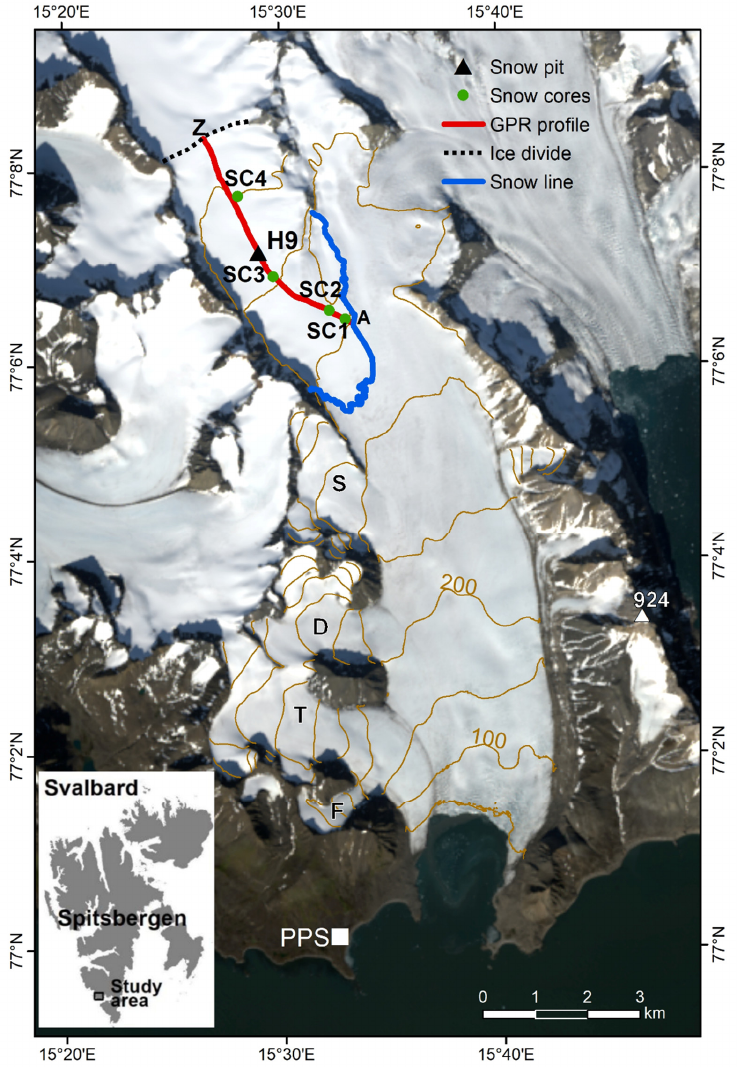
Figure 1. Location of the study area and location of radio-echo sounding (RES) in the accumulation zone (red line AZ), and snow pit H9 on the background of LandSat 8, August 2017. The snow line indicated is dated 26 August 2017. Capital letters stand for tributary glaciers: F—Fuglebreen, T—Tuvbreen, D—Deileggbreen, S—Staszelisen. The white square represents the Polish Polar Station (PPS). Contour line interval: 50 m. (geodata.npolar.no).